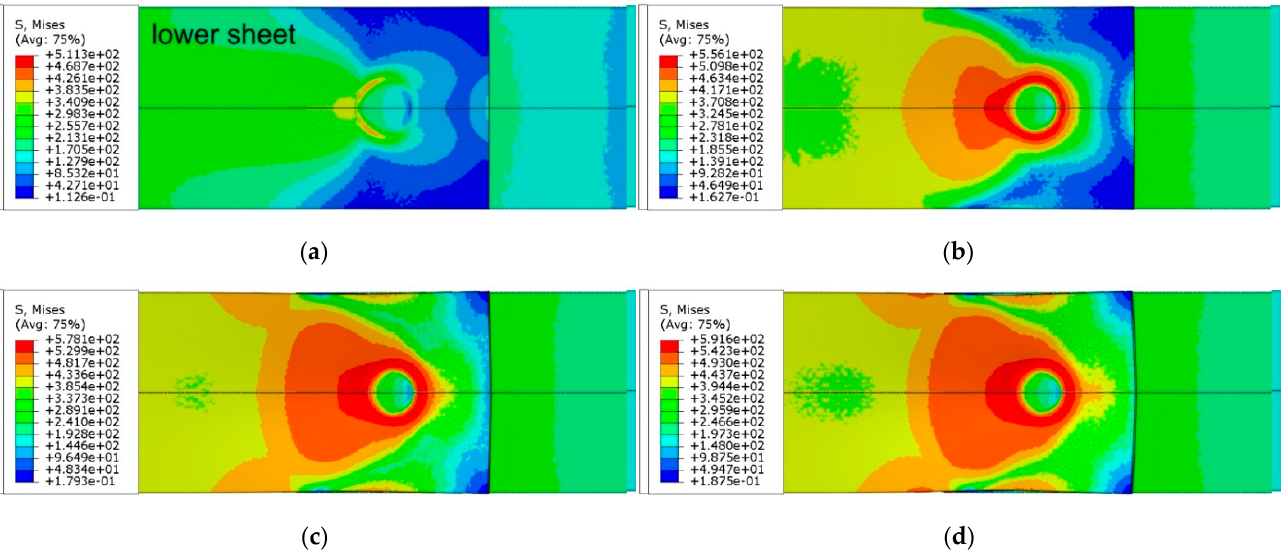
Figure 23. Distribution of equivalent von Mises stress (in MPa) in the RFSSW joint under tensile shear loading at different displacements (view on the bottom of weld): ( a ) 0.45 mm, ( b ) 0.9 mm, ( c ) 1.35 mm and ( d ) 1.8 mm.